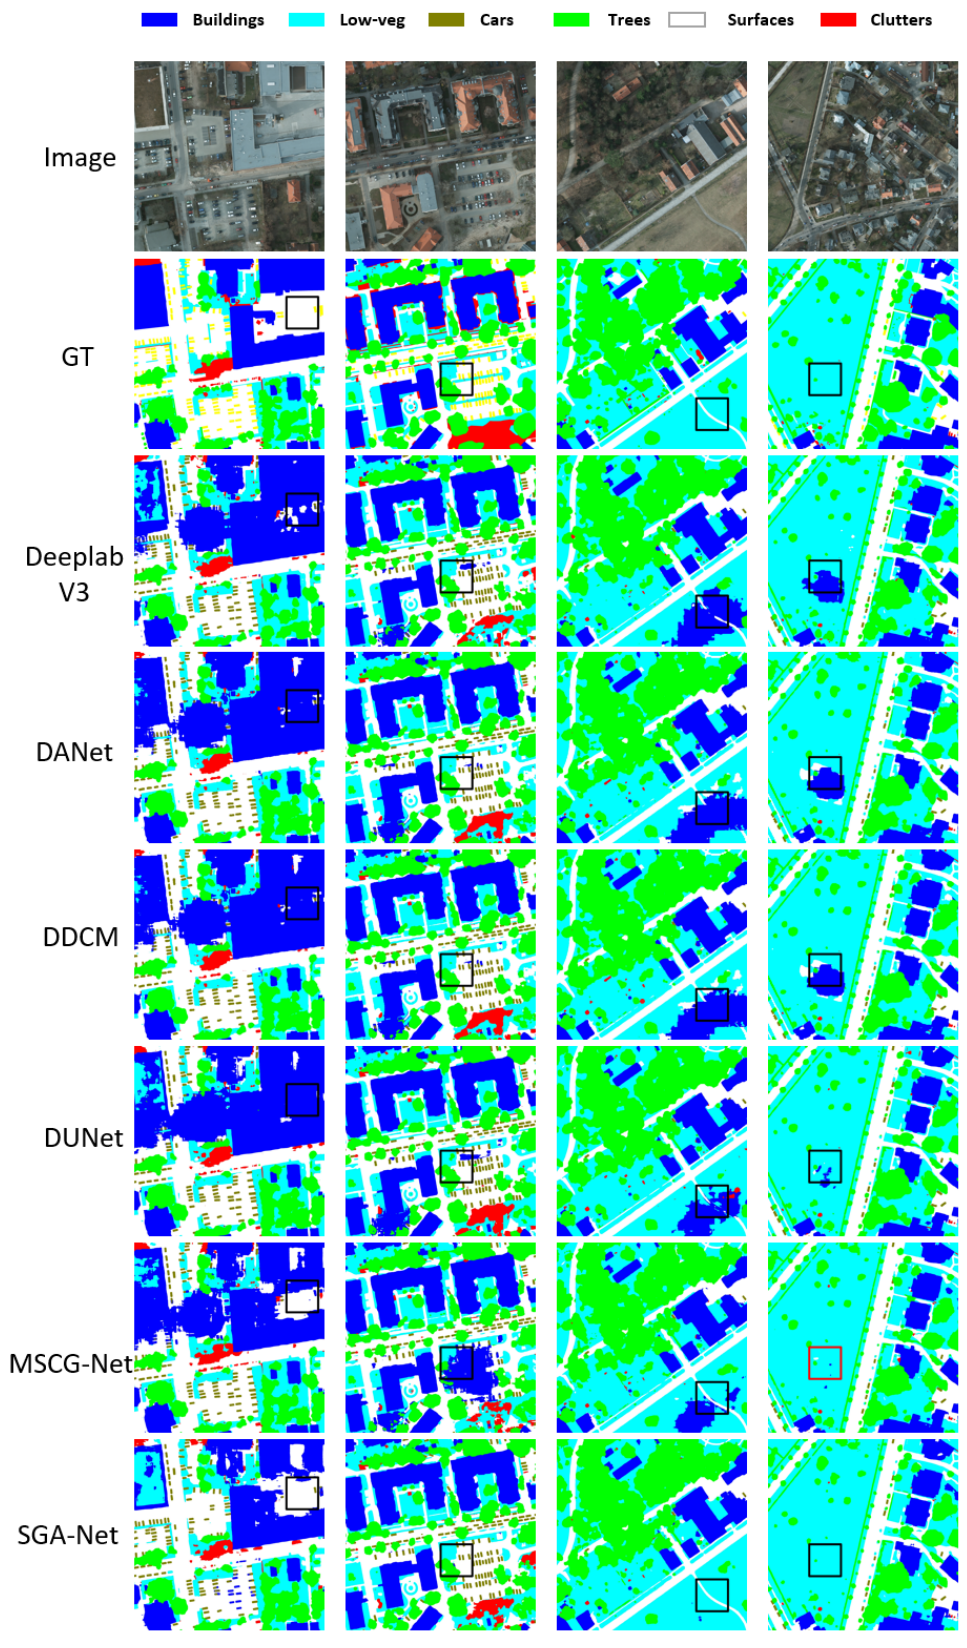
Figure 4. Visualization of prediction detail in the Potsdam